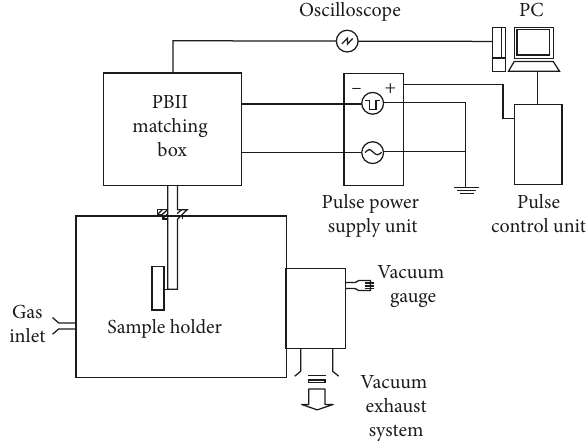
Figure 1: Schematic of the PBII apparatus used in this experiment